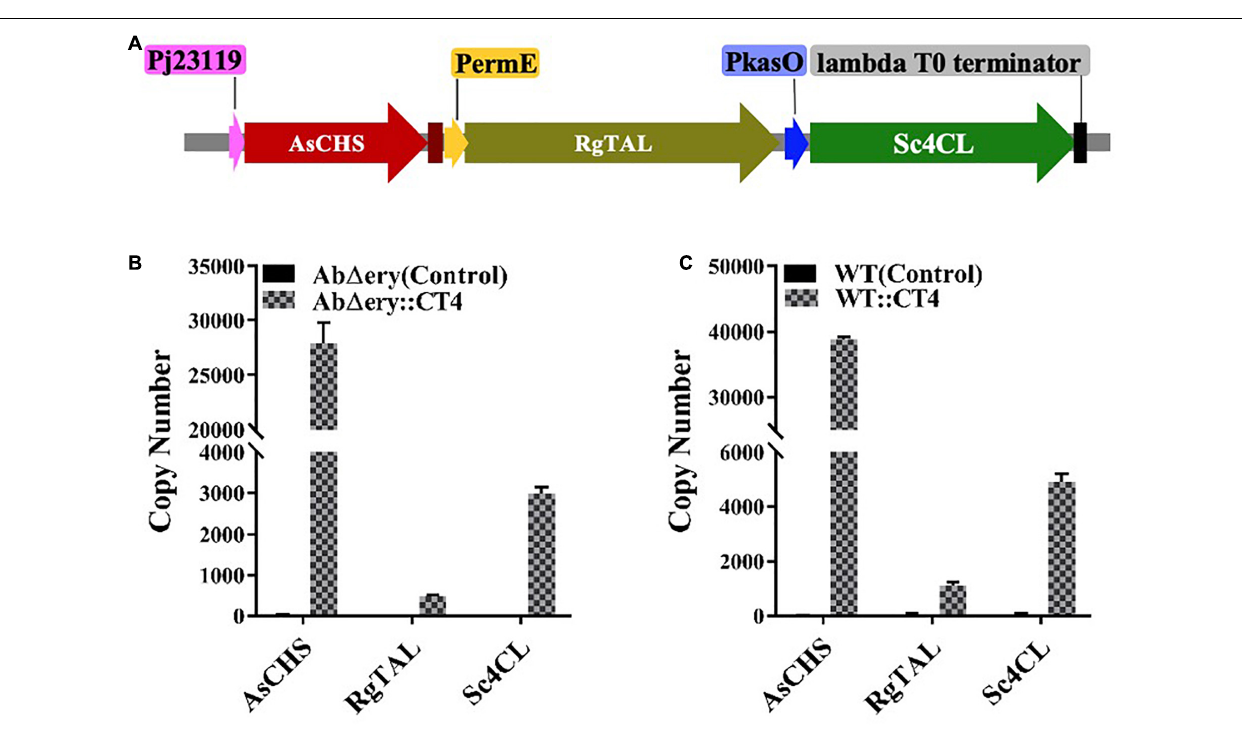
The plasmid pSET152-Pj23119-AsCHS-PermE-RgTAL- PkasO-Sc4CL was transformed into Ab (cid:49) ery and WT protoplasts. Positive colonies Ab (cid:49) ery :AsCHS-RgTAL-Sc4CL